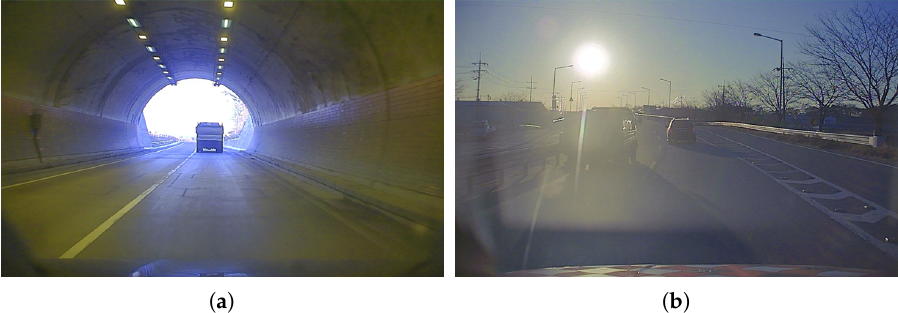
Figure 10. Examples of tunnel and twilight image: ( a ) tunnel image, and ( b ) twilight image.